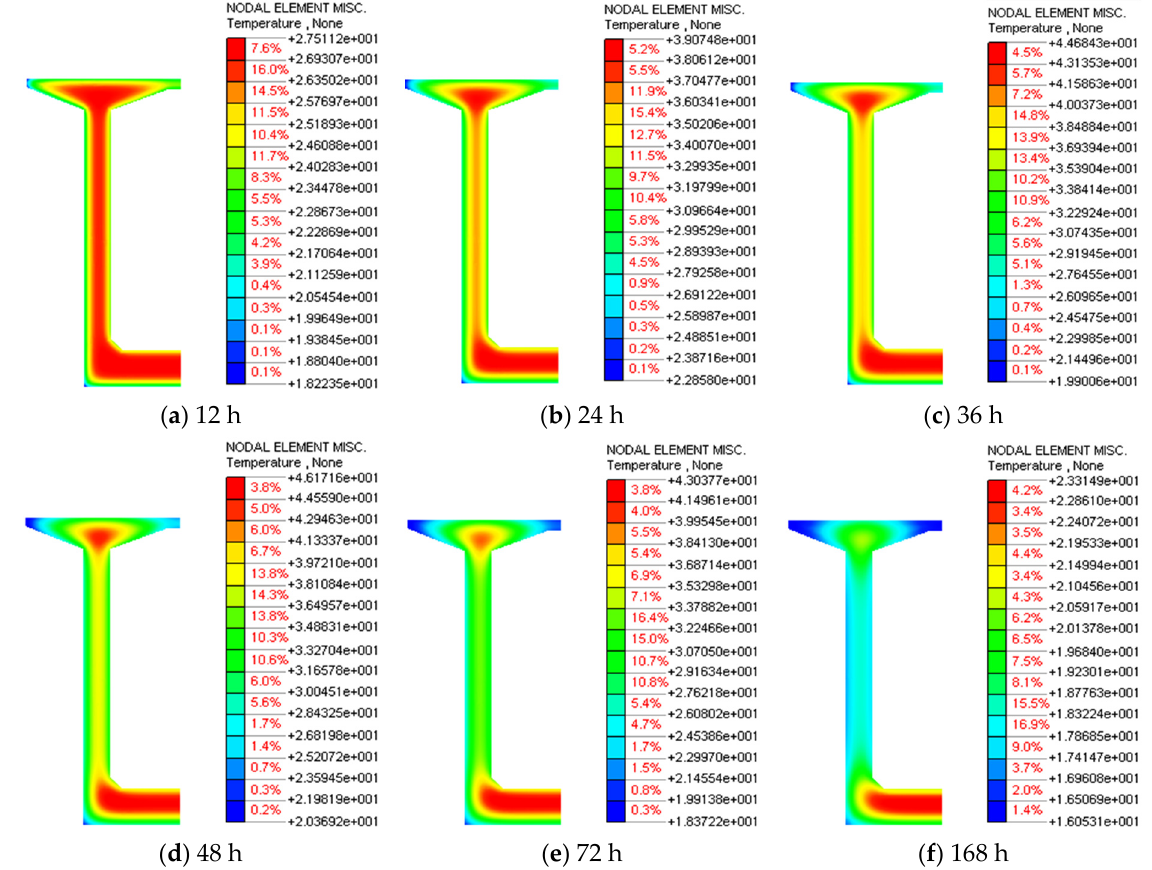
Figure 10. Temperature field distribution clouds of box girder section at each moment.